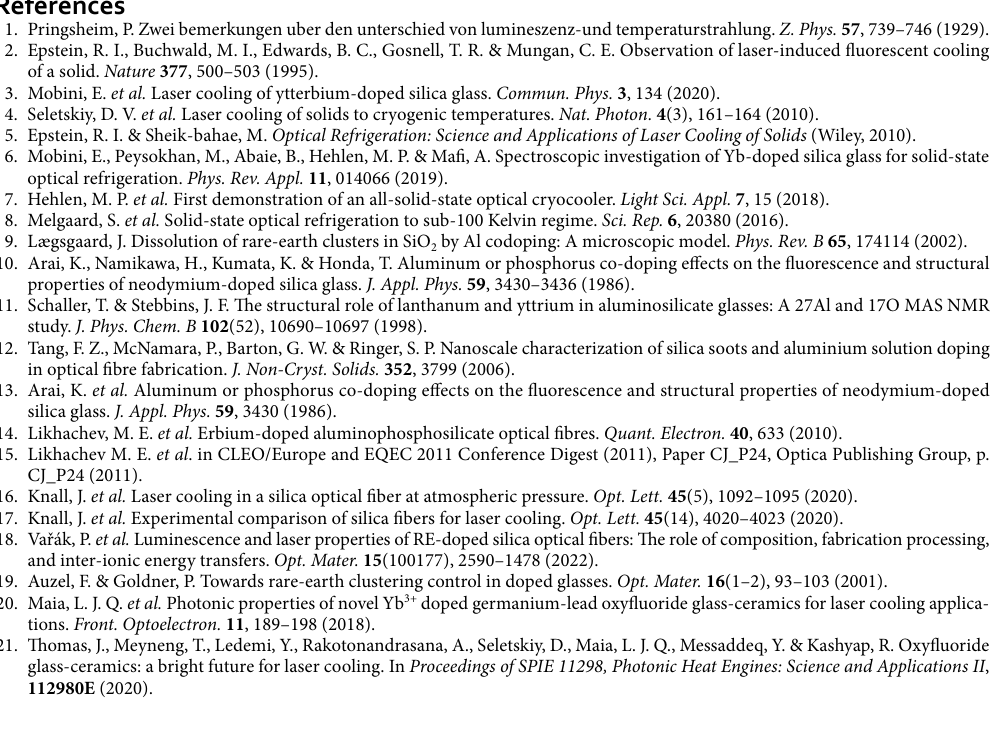
slot blades operating at a frequency of 20.0 Hz 27 . The background absorptive loss measurements were made using fiber Bragg grating (FBG) direct contact technique with an IPG ELR-70-1550-LP 1550 nm ytterbium-erbium fiber laser at 5 W, as a source of optical power 49 . Laser cooling measurements were done by evaluating the steady-state temperature change of the glasses while exciting with a 1029 nm laser (Pharos) with varying pump powers ranging from 0.5 to 6.5 W. The maximum peak power density of 1.708e + 8 W/cm 2 used in our measurements showed no optical damage. The samples were supported by a pair of silica optical fibers, which were adhered to a stainless-steel holder located inside an aluminum chamber to minimize the heat load on the samples. A schematic of the experiment is depicted in Fig. 6. To monitor the temperature, the fiber Bragg grating (FBG) direct contact method 27,49,50 was employed. The shift in central wavelength of the FBG is directly proportional to the temperature change of the sample. A thermal camera (FLIR) was also employed to measure the temperature change upon laser irradiation at 1029 nm.